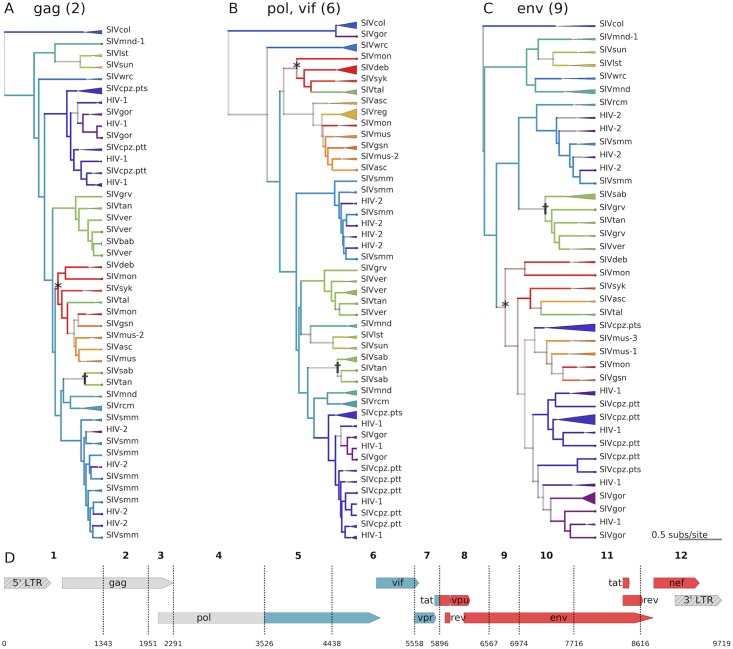
Lentiviral phylogenies highlighting the mosaic origins of SIVcpz and examples of how CST is inferred from the phylogenies A,B,C.Bayesian maximum clade credibility (MCC) trees are displayed for segments 2 (gag—A), 6 (int and vif—B), and 9 (env–C) of the main dataset (N = 423). Tips are color coded by known host species; internal nodes and branches are colored by inferred host species, with saturation indicating the confidence of these assignments. Monophyletic clades of viruses from the same lineage are collapsed, with the triangle width proportional to the number of represented sequences. An example of likely cross-species transmission is starred in each tree, where the host state at the internal node (red / mona monkeys) is incongruent with the descendent tips' known host state (green / talapoin monkeys), providing evidence for a transmission from mona monkeys to talapoin monkeys. Another example of cross-species transmission of a recombinant virus among African green monkeys is marked with a dagger. D—The genome map of SIVcpz, with breakpoints used for the discrete trait analysis, is color coded and labeled by the most likely ancestral host for each segment of the genome.